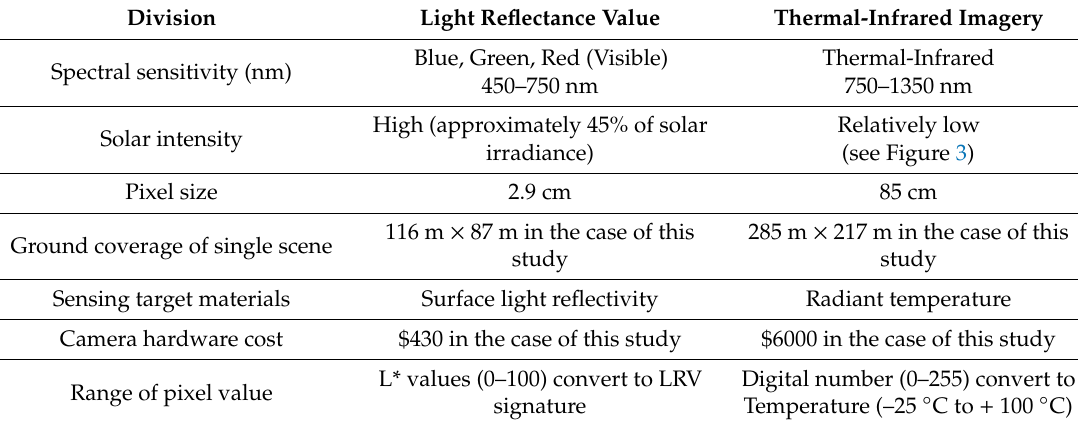
Figure 6. Correlation between LRV versus surface temperature according to rooftop color (a: white, b: gray, c: blue, d: cyan, e: red, f: green, g: black and h: brown). LRV distribution range ( A – C ) according to rooftop surface temperature ( A : whitish, B : intermediate, C : blackish). Table 4. Comparison of LRV versus thermal-infrared